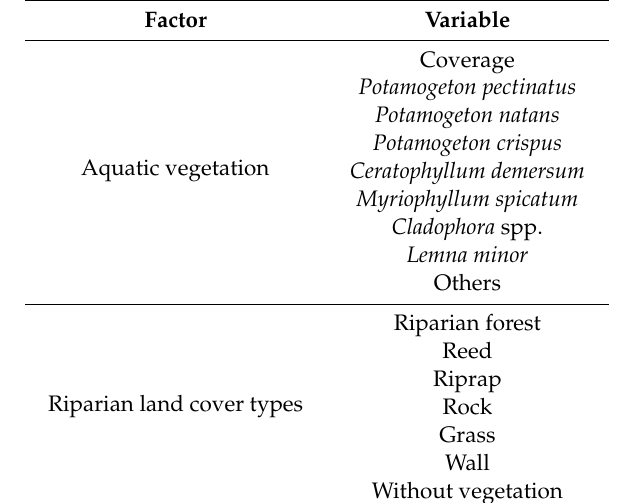
Table 2. Habitat variables recorded at each sampling point. All point measurements were converted to percentages to describe their relative distribution at each